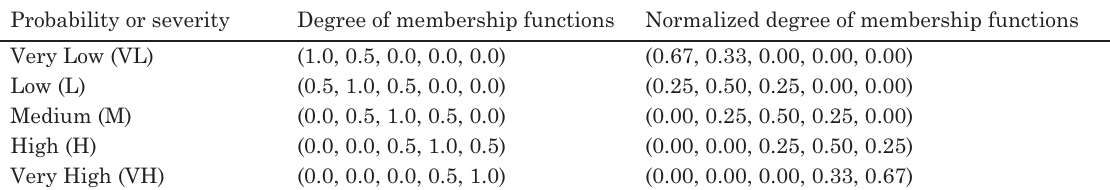
table 4. Membership function for each possible risk perception